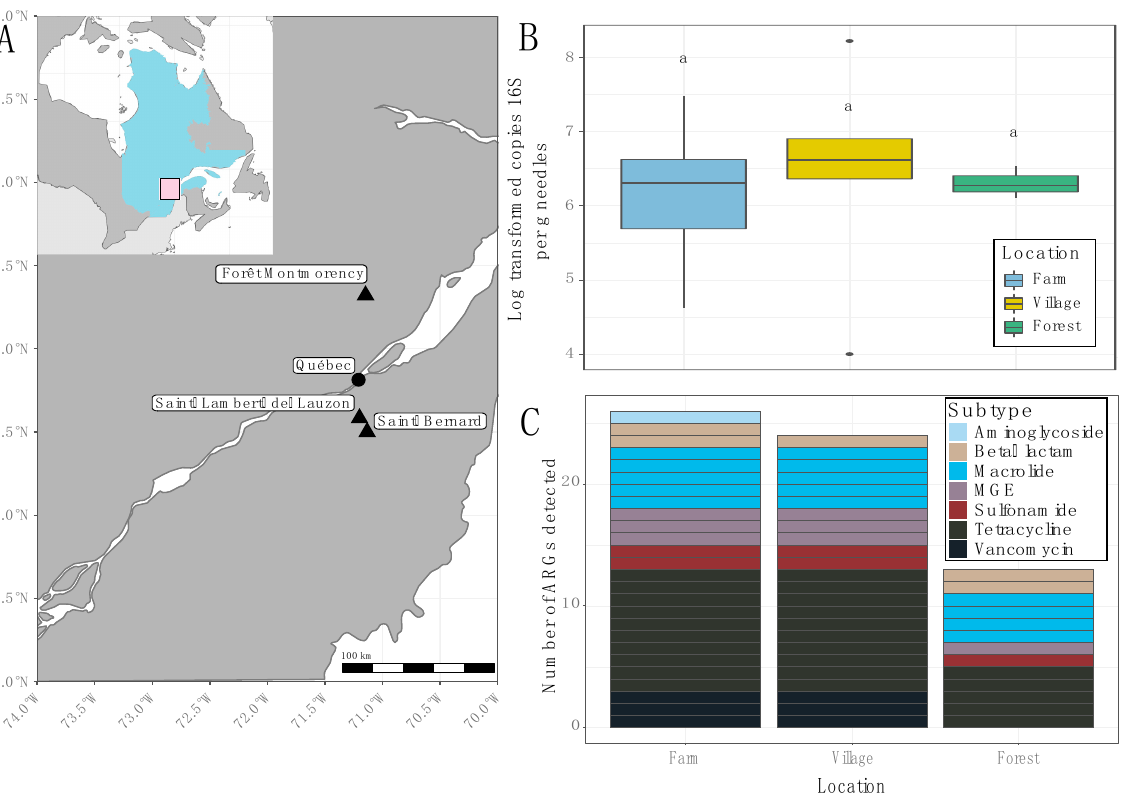
Figure 1. Summary information of conifer needle samples. ( A ) Sampling sites in the province of Québec, Canada; inset map shows the position of Québec within Canada. ( B ) Biomass estimates based on log-transformed copy number of 16S rRNA gene per g of conifer needles. Boxes represent the data within the first and third quartiles; the horizontal line marks medians; whiskers represent 1.5 × the interquartile range. ( C ) Total number of ARGs detected via qPCR at each sampling